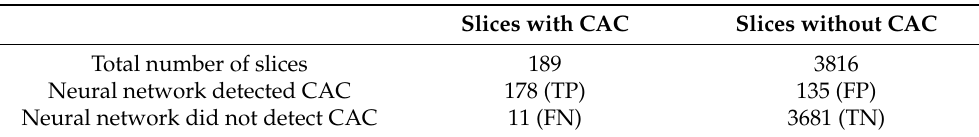
Table 1. Distribution of slices with and without CAC and those detected and not detected by the neural network.